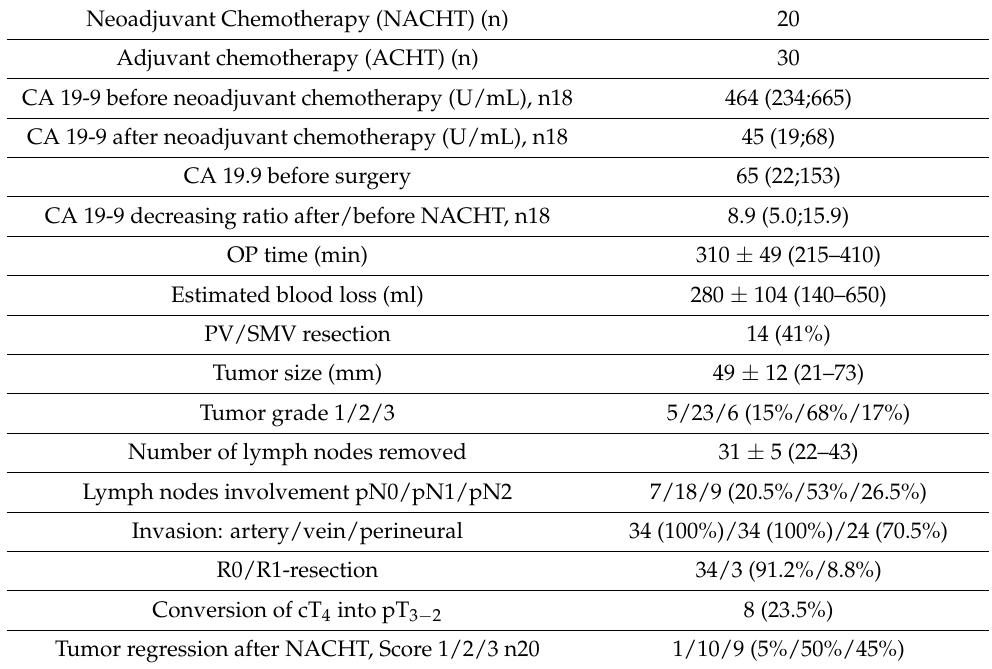
Table 3. Perioperative characteristics of the patients with PDAC